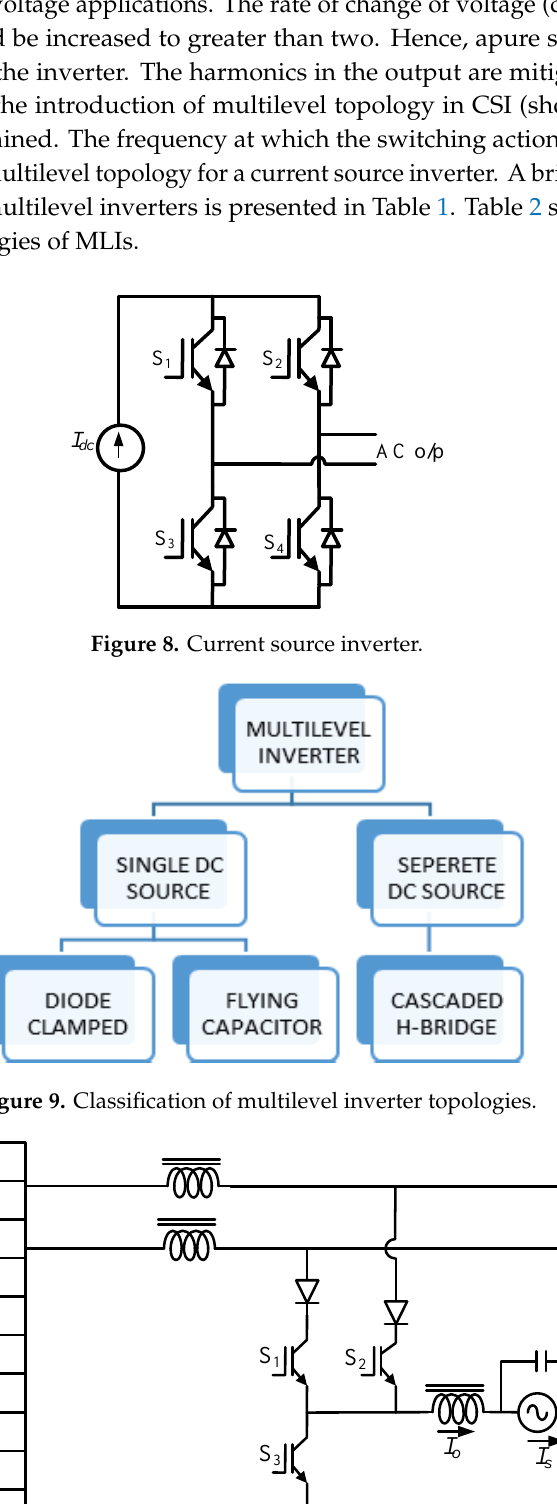
Figure 9. Classification of multilevel inverter topologies.